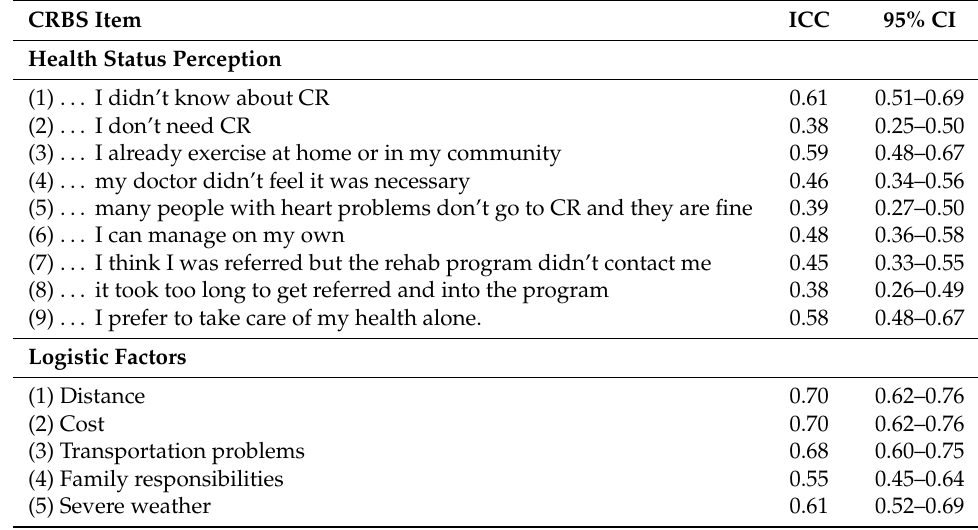
Table 3. Test–retest reliability of the Cardiac Rehabilitation Barriers